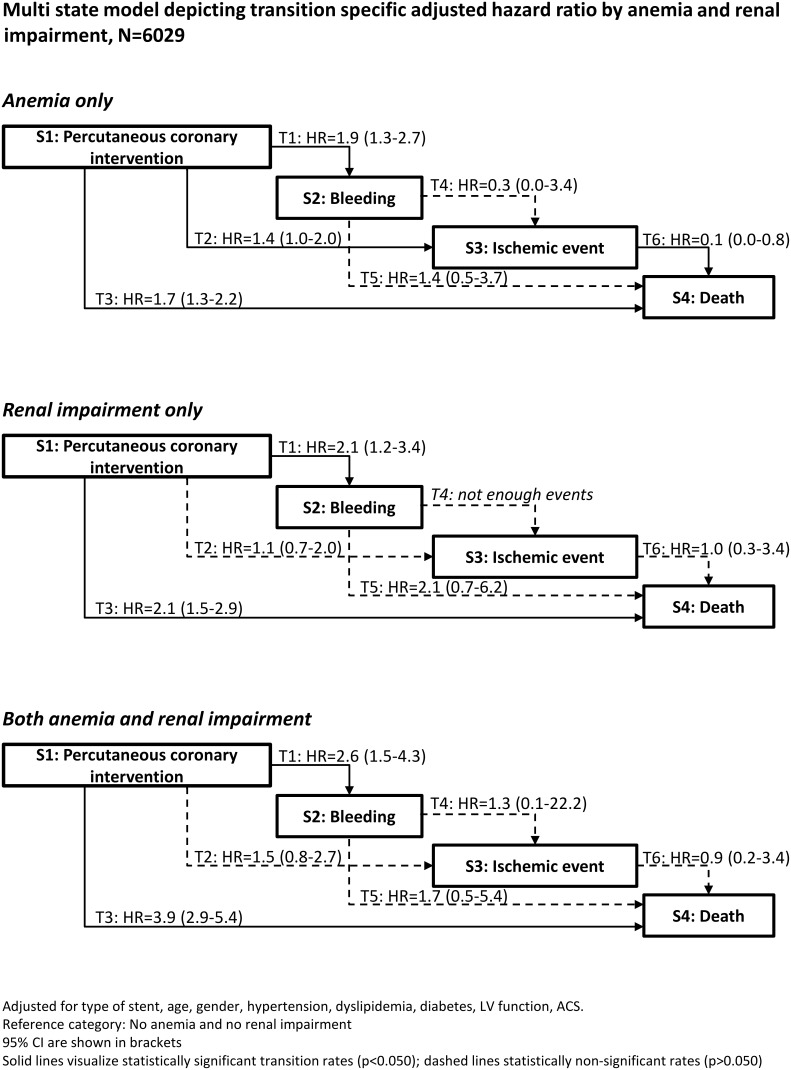
shows a multi-state model depicting transition-specific adjusted hazard ratios with 95% CI by anemia and renal impairment.